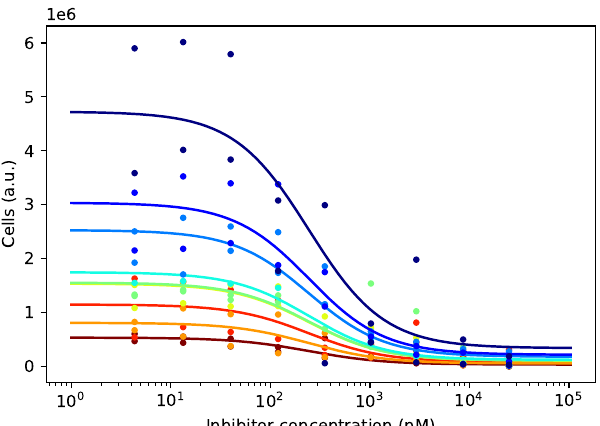
Figure 3. Different cell lines have different growth patterns, and after 72 h of incubation, their numbers differ significantly at every drug concentration. Curves differing only in the amplitude parameter A 0 and sharing the remaining three parameters, b ∞ , logC , and β , were fitted to the empirical data. The different amplitudes were later used for normalizing the